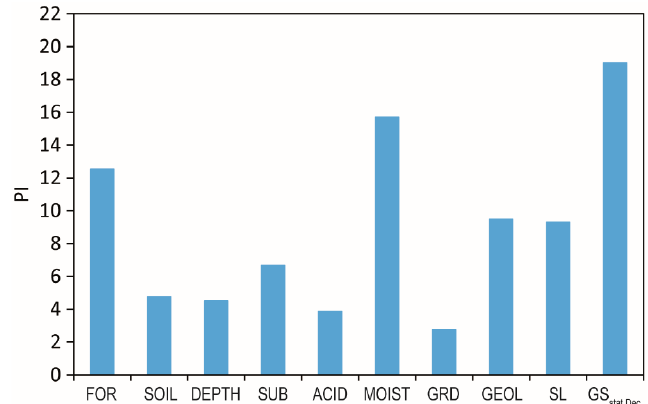
Figure 8. Predictor Importance ( PI ) of random forests model output for modeled endemic storm damage